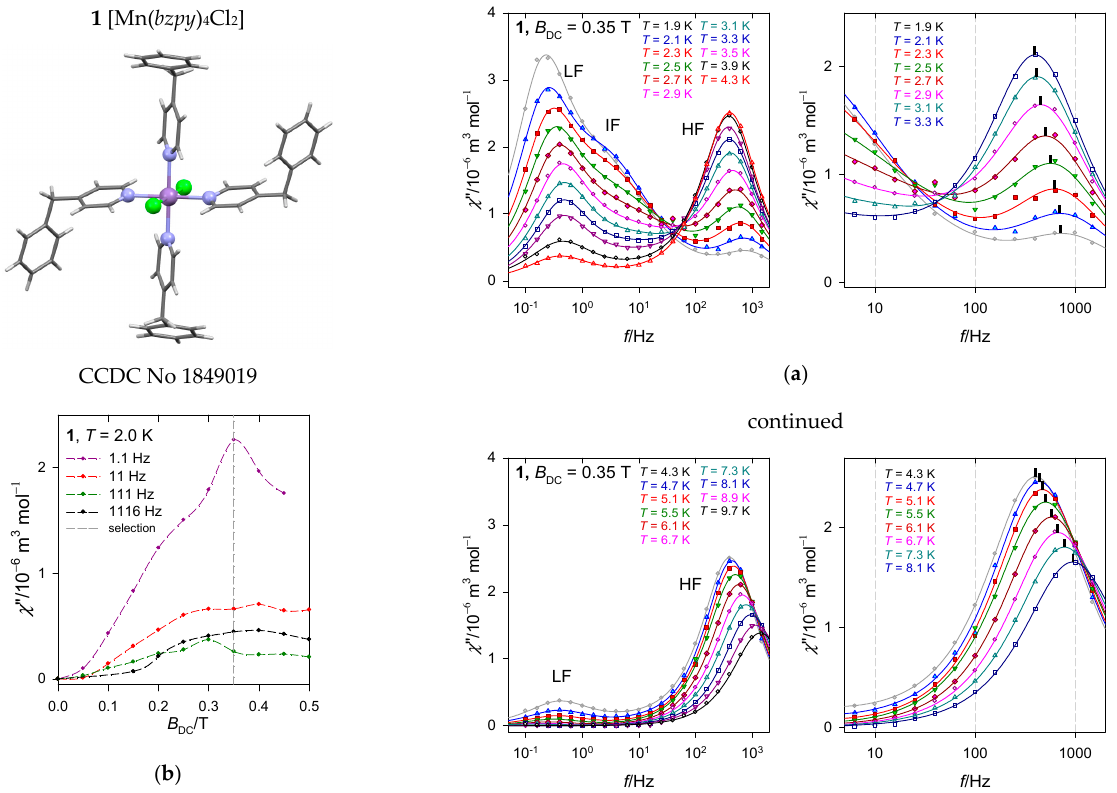
Figure 7. Frequency dependence of the out-of-phase susceptibility at various temperatures and external fields for [Mn( bzpy ) 4 Cl 2 ]. ( a ) Left—full scale of data taking, right—zoomed high-frequency range truncated for clarity. Solid lines—fitted. ( b ) field dependence. Vertical mark envisages the maximum on χ ”; notice its movement on heating to a slower relaxation and then back to the faster one. Data adapted from ref. [52]. 2019, American Chemical Society. Table 4. Fitted relaxation times of the Debye model for [Mn( bzpy ) 4 Cl 2